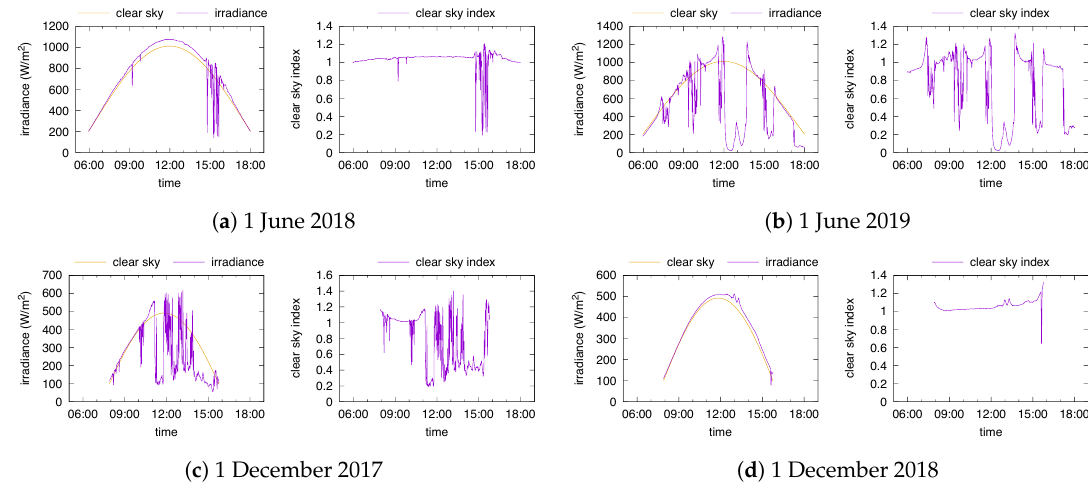
Figure 2. Global and clear sky irradiance ( left ) and clear sky index ( right ) in Golden for four selected